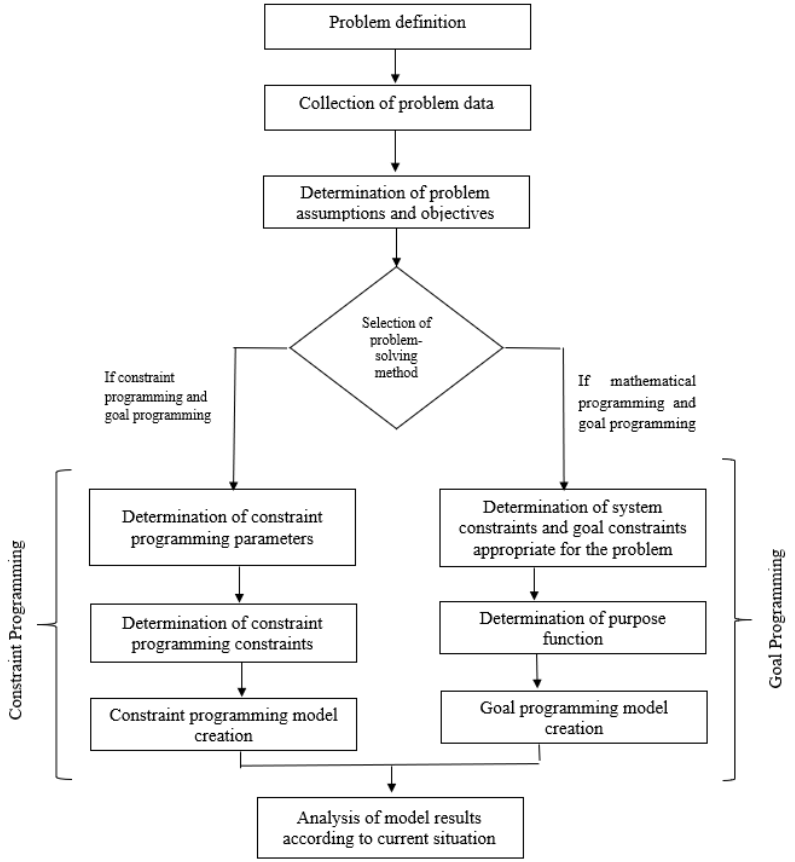
Figure 1. Case study flowchart.